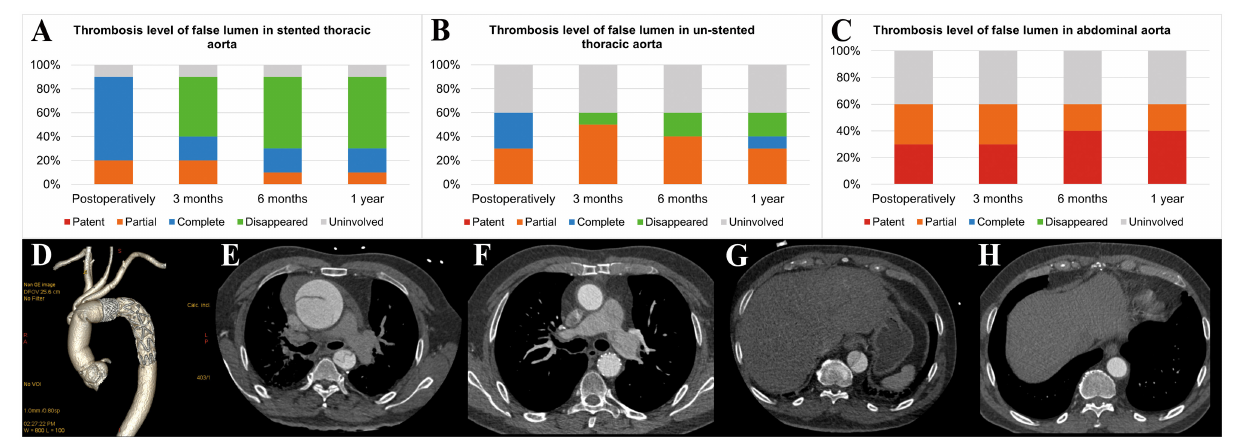
FIGURE 4 | Aortic remodeling after surgery. (A) Proportions of different FL thrombosis levels in the stented thoracic aorta at different time points after surgery. (B) Proportions of different FL thrombosis levels in the unstented thoracic aorta at different time points after surgery. (C) Proportions of different FL thrombosis levels in the abdominal aorta at different time points after surgery. (D) The 3D reconstruction of aortic CTA shows the appearance of the SIS graft prosthesis after AAR + TAR + FET implantation surgery. (E–H) The axial view of aortic CTA presents comparisons of the aorta preoperatively and 3 months postoperatively in the same patient who underwent Bentall + AAR + TAR + FET implantation. (E) At the pulmonary artery bifurcation level, the intimal flap, TL and FL could be seen clearly in the ascending aorta and descending aorta preoperatively. (F) The ascending aorta was replaced with a terylene vascular graft, and the FL completely disappeared after FET implantation. (G) At the T10 level, the intimal flap, TL and FL could be seen clearly in the descending aorta preoperatively. (H) The FL disappeared in the unstented region by 3 months postoperatively. FL, false lumen; 3D, three-dimensional; CTA, computed tomography angiography; AAR, ascending aorta replacement; TAR, total arch replacement; FET, frozen elephant trunk; TL, true